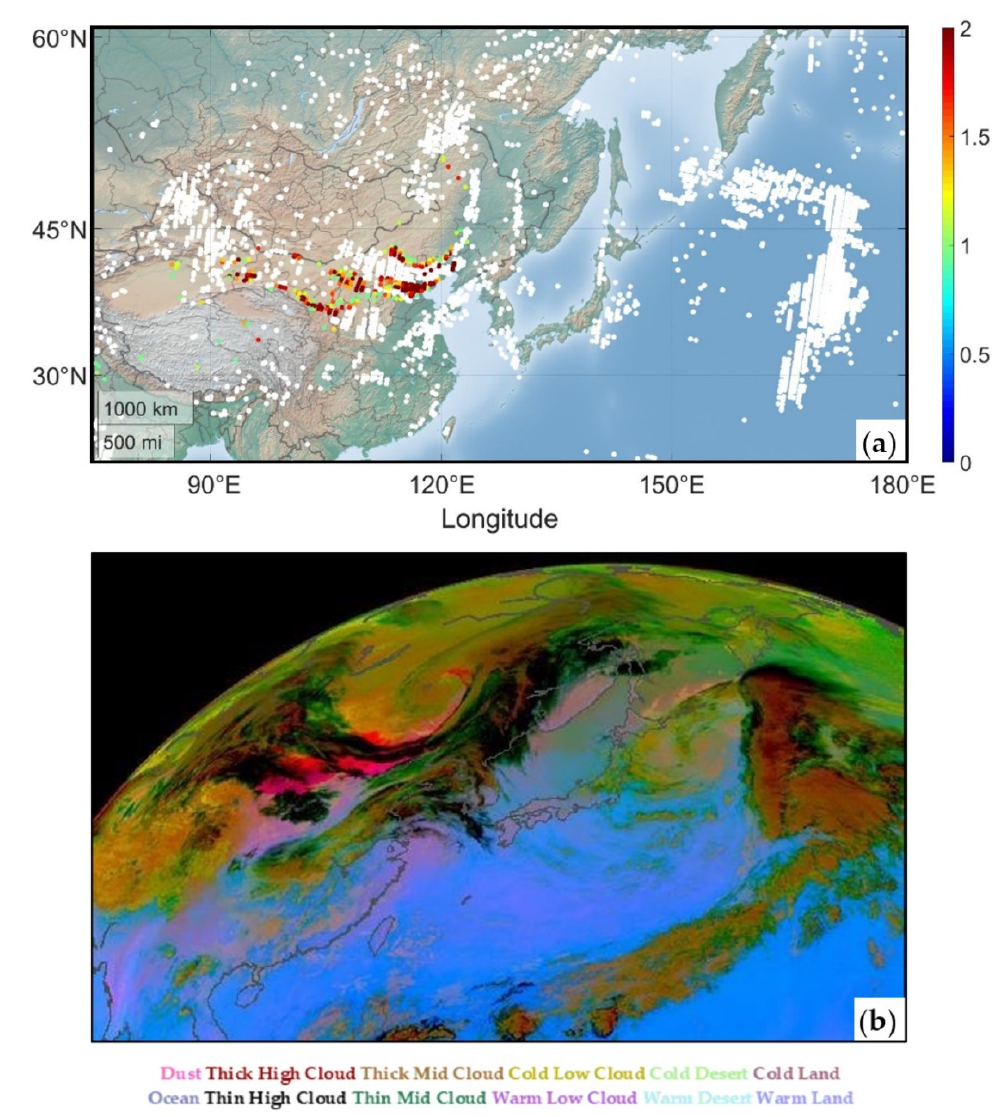
Figure 8. ( a ) IASI dust and cloud selection on 15 March 2021; ( b ) RGB Dust False-like SEVIRI from HIMAWARI (www.icare.univ-lille.fr, accessed on 1 December 2021).